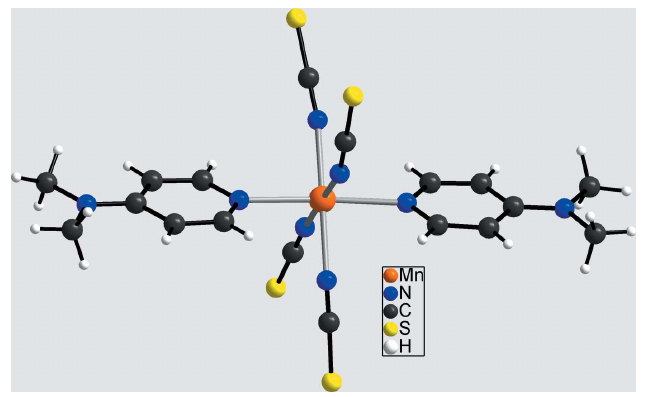
Figure 1 View of the Mn coordination in bis[4-(dimethylamino)pyridinium] bis[4- (dimethylamino)pyridine- (cid:4) N ]tetrakis(thiocyanato- (cid:4) N )manganate(II). Data taken from Wo¨hlert et al. (2012 b